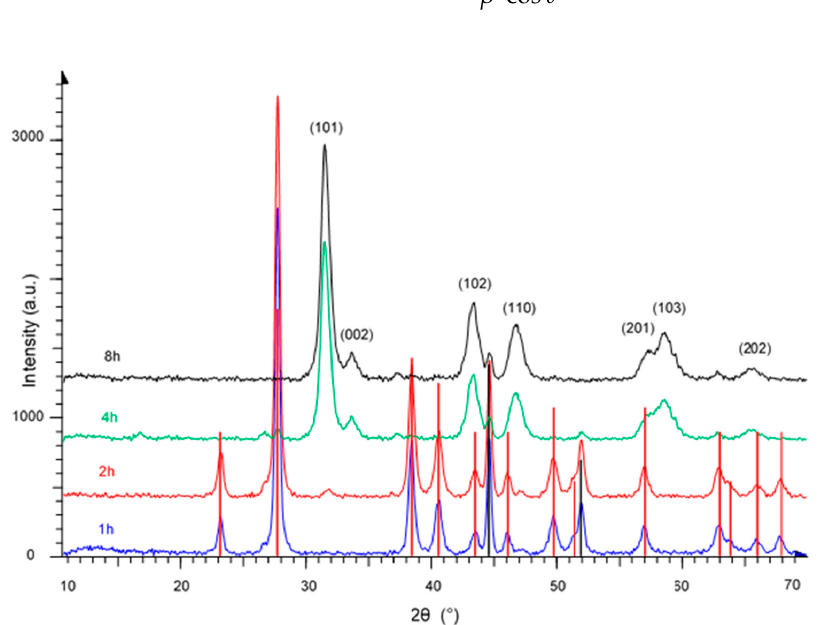
Figure 1. XRD patterns of NiTe prepared mechanochemically after 1 h, 2 h, 4 h, and 8 h milling time. Black and red vertical lines represent the precursors Ni and Te, respectively.